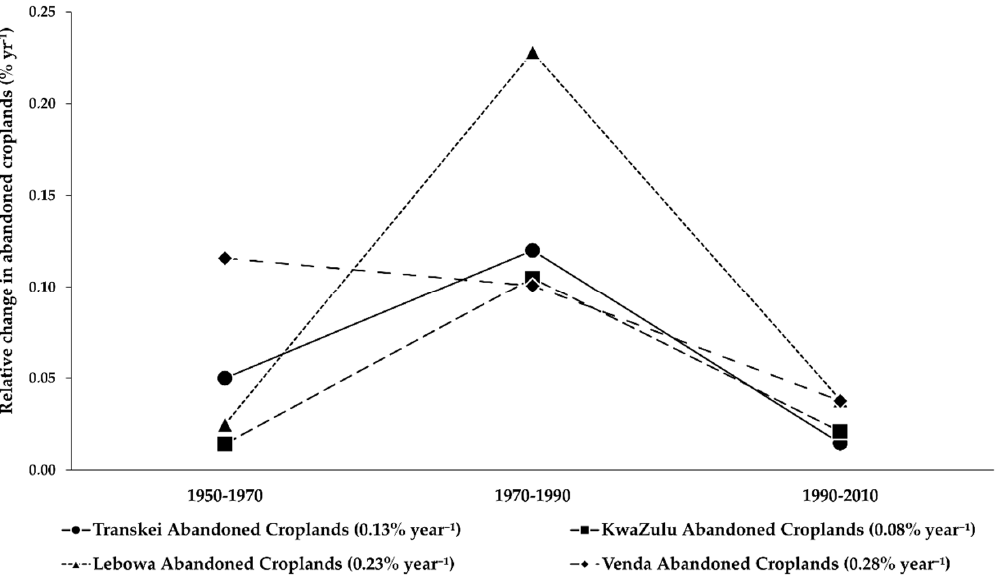
Figure 3. Change in abandoned cropland cover relative to the starting land cover in each period (% year − 1 ). Annualised relative land cover rates from 1950–2010 are listed for each area in the